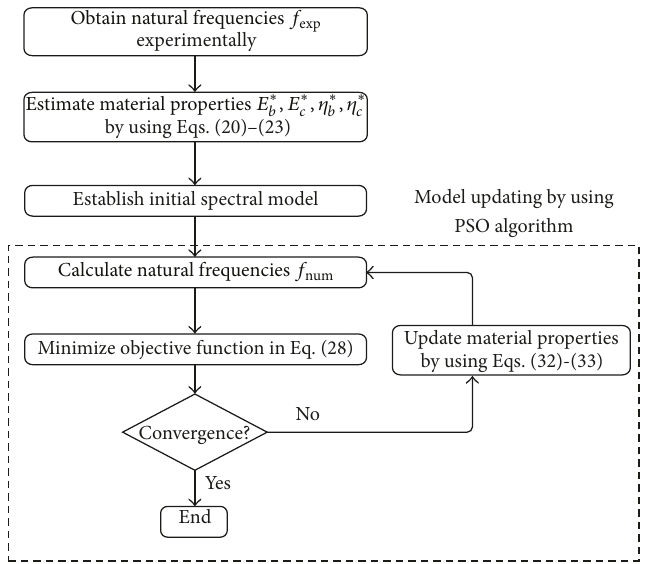
Figure 2: Flowchart of the parameter identification procedure combining spectral model and PSO algorithm.